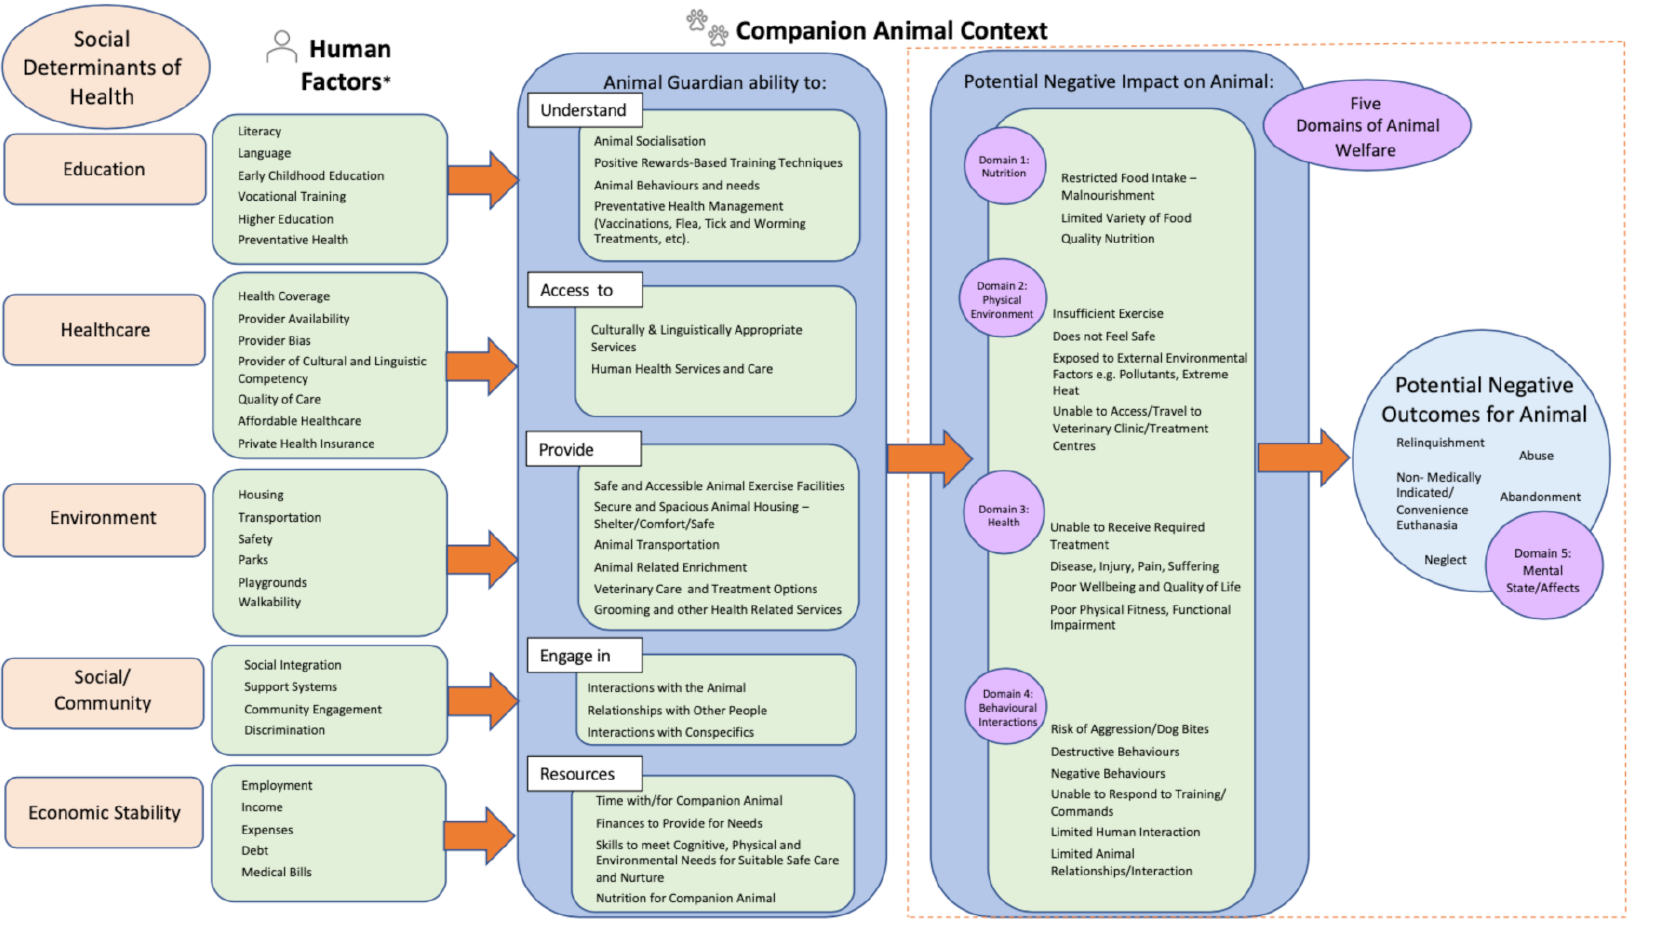
Figure 1. Five domains of SDH that influence animal guardians’ ability to care for their companion animal(s) and the potential negative outcomes on animal welfare. * Adapted from ‘Healthy People 2030 (cid:48) , US Department of Health and Human Services, Office of Disease Prevention and Health